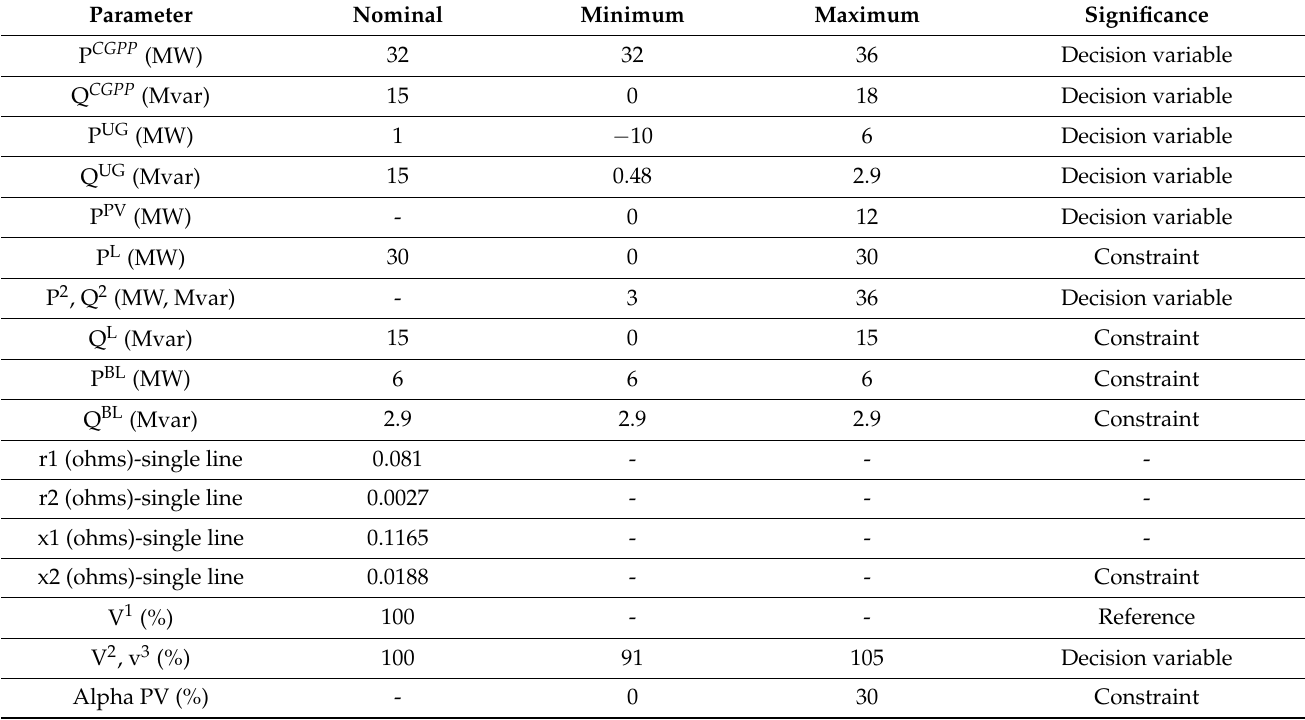
Table 5. Industry technical